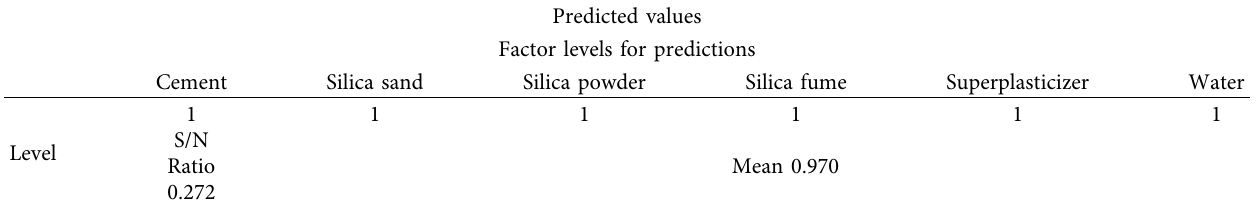
Table 18: RPC mix design predicted by Minitab for water